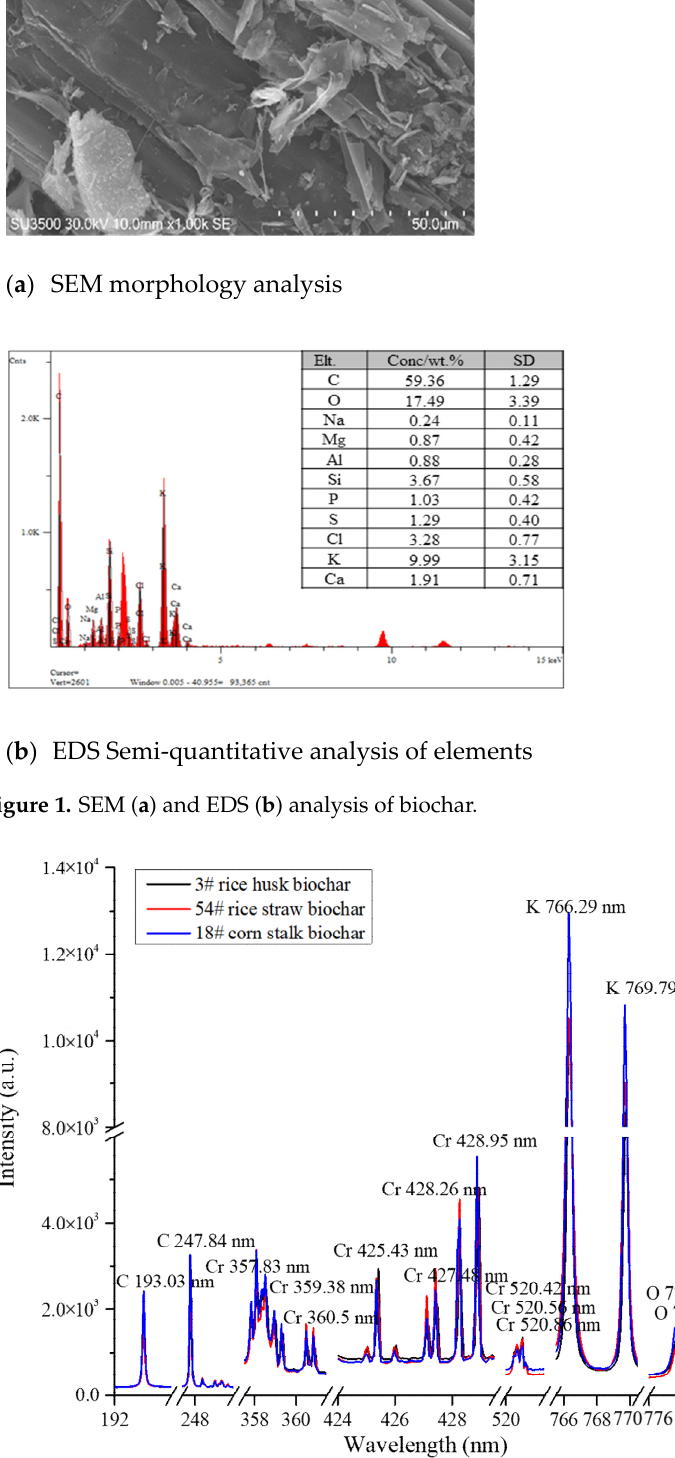
Figure 2. LIBS spectra of